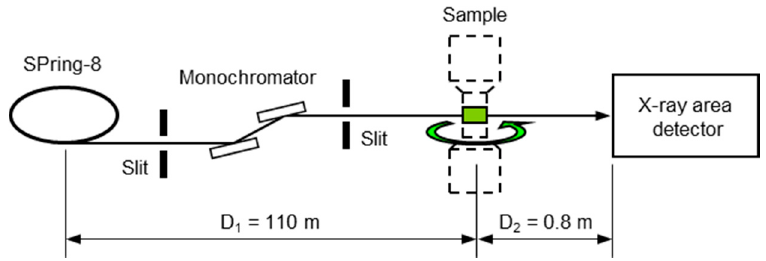
Figure 3. The CT setup with a phase-contrast effect at BL19B2 of SPring-8.